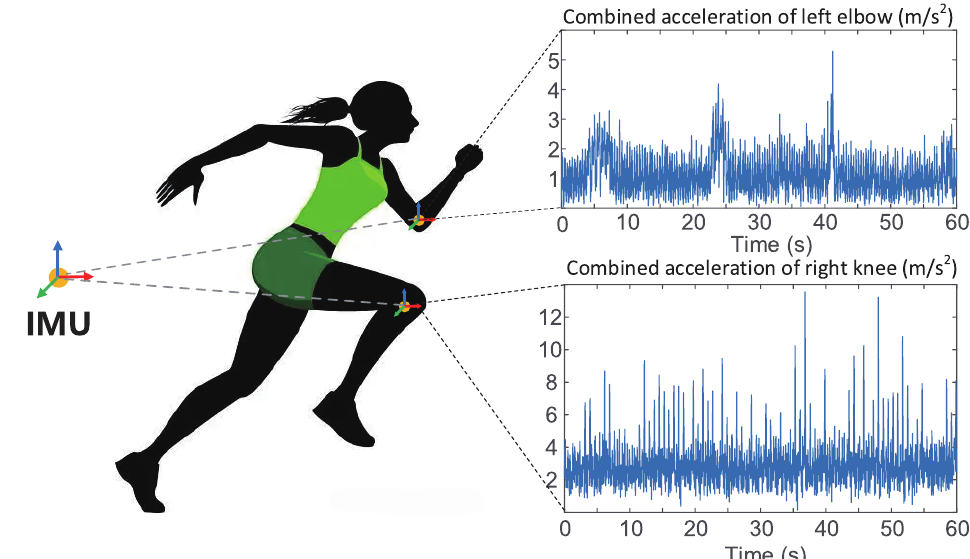
Figure 2. Diagram of human activity recognition based on inertial measurement unit (IMU) [37]. Two IMUs are placed on the arm and leg respectively to record the motion pattern at each position for further recognition of human motion. As can be seen from the figure, there are some differences in the data collected from different limbs. Reprinted with permission from Ref. [37]. Copyright 2020 IEEE.